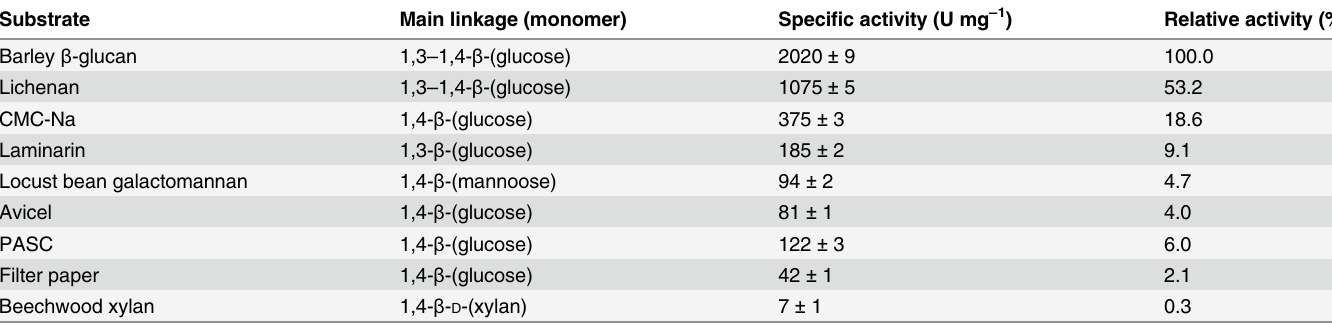
Table 1. Substrate specificity of the recombinant